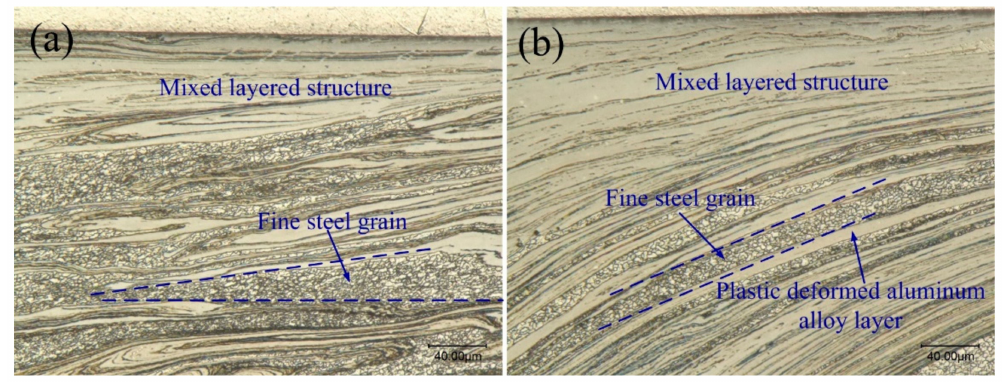
Figure 10. Mixed layered structure showing fine steel grain. ( a ) Middle part of interfacial zone; ( b ) advancing side of interfacial zone.